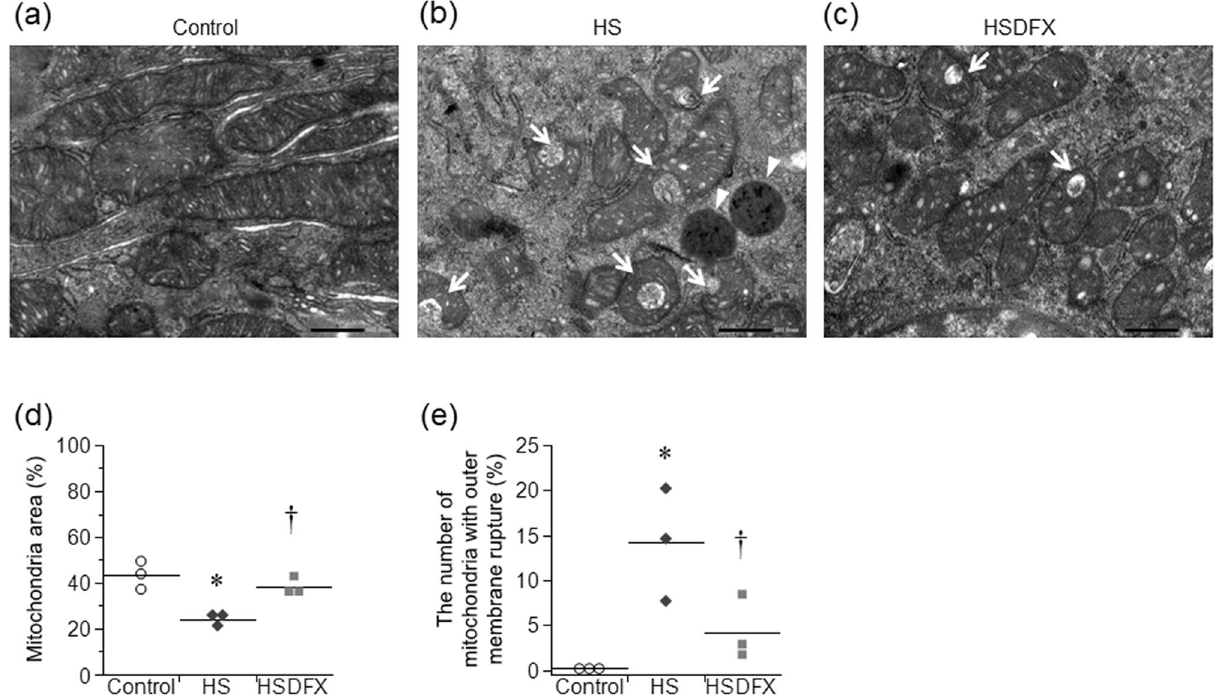
Figure 7. Mitochondrial damage in the renal proximal tubular epithelial cells. The electron micrographs show the mitochondria in the renal proximal tubular epithelial cells in the control group ( a ), the HS group ( b ), and the HSDFX group ( c ) (bars 500 nm). Panel ( d ) shows the percentage of mitochondria area in cytoplasm. Panel ( e ) shows the percentage of mitochondria with outer membrane rupture in the total number of mitochondria. (n = 3 for each group, Arrow: outer mitochondrial membrane rupture, Arrowhead: lysosome). Statistical analysis was performed using one-way analysis of variance followed by Tukey–Kramer test in ( d ) and ( e ) by JMP